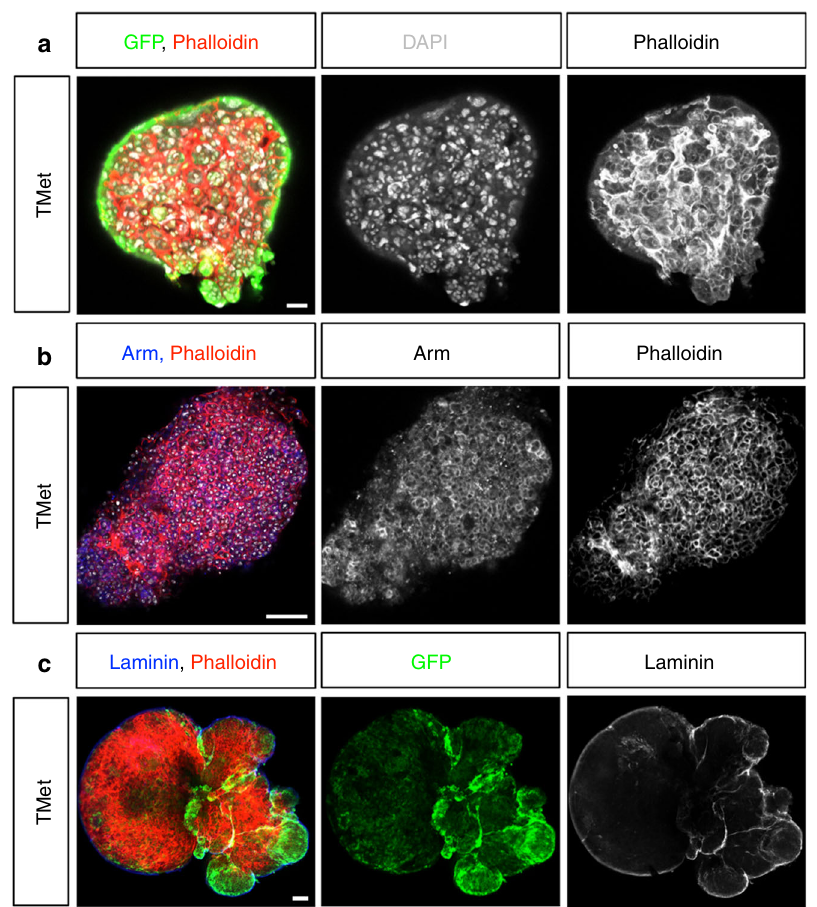
Fig. 6 Early metastases do not show epithelial traits. Metastatic tumors stained for green fl uorescent protein (GFP) and F-Actin ( a , phalloidin, red); Armadillo (Arm) and F-Actin ( b , Arm, blue; phalloidin, red); and GFP, Laminin and F-Actin ( c , Laminin, blue; phalloidin, red). Scale bars: 50 µ